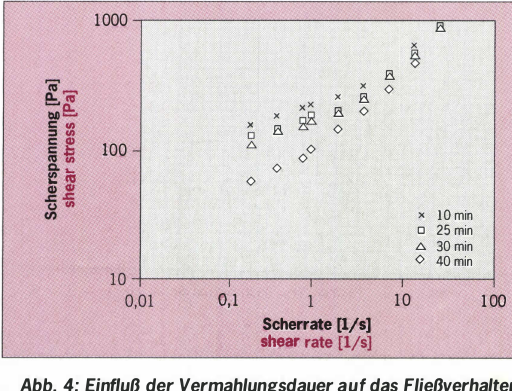
Fig. 4: Effect of grinding time on flow els are also suitable for other applications.